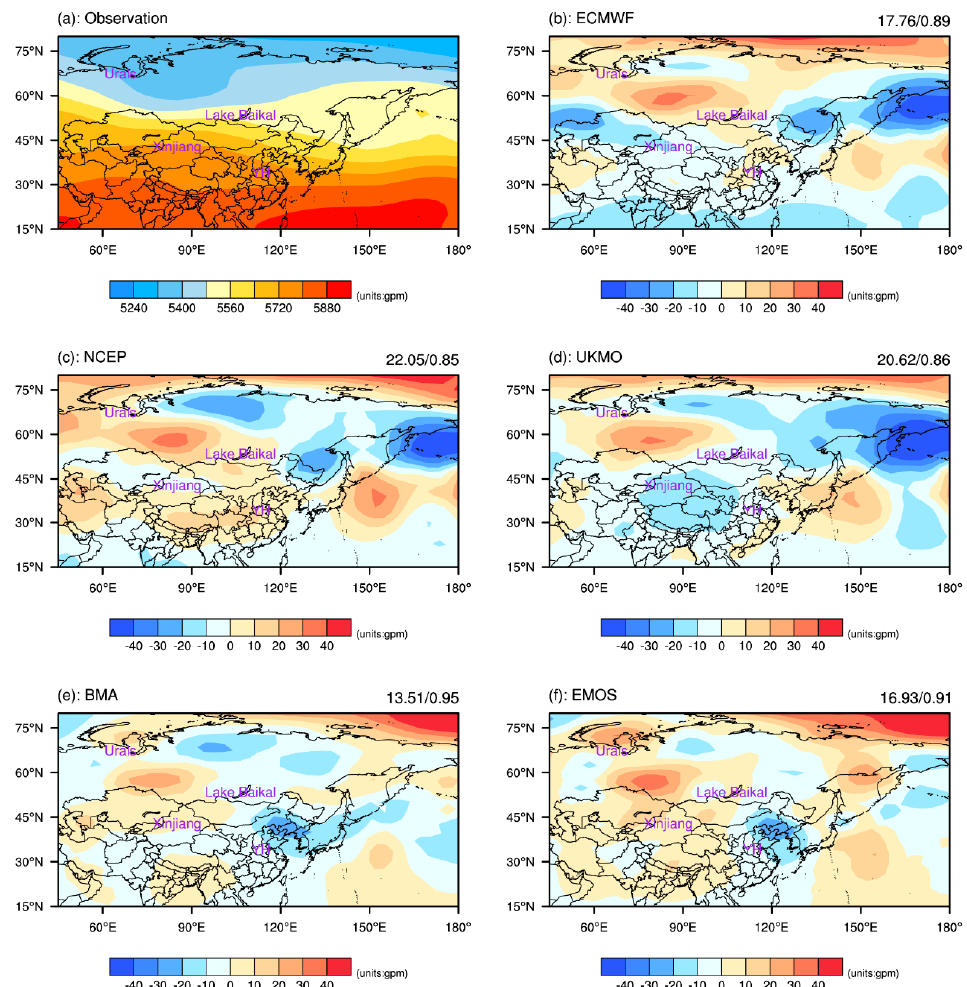
Figure 1. Mean 500 hPa geopotential height distribution from 23 April to 30 May 2013 for ( a ) the observations, the difference between the observations and the ensemble mean of the ( b ) European Centre for Medium-Range Weather Forecasts (ECMWF), ( c ) National Centers for Environmental Prediction (NCEP), and ( d ) UK Met Office (UKMO) ensemble prediction systems (EPSs) with a lead time of 7 days and the difference between the observations and the deterministic forecast of the ( e ) Bayesian model averaging (BMA) and ( f ) ensemble model output statistics (EMOS) with a lead time of 7 days. The root mean square error and anomaly correlation coefficient between the forecasts and the observations are shown in the upper right-hand corner of each part. The purple labels denote the place named Ural Mountains, Lake Baikal, Yellow, and Huaihe river basins (YH), and Xinjiang